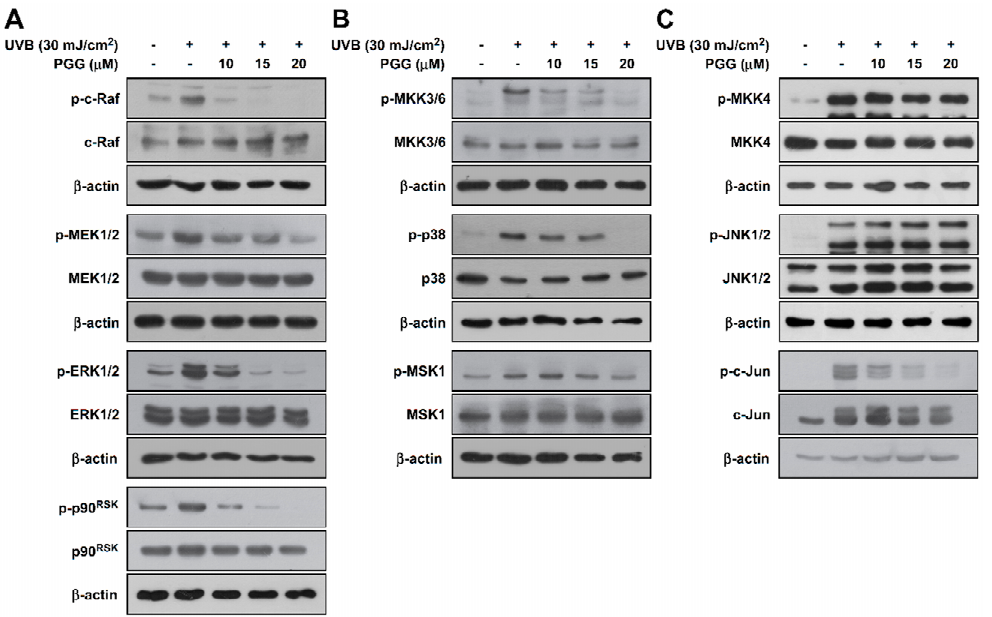
Figure 2. Effect of PGG on UVB-induced MAPK signaling in HaCaT cells. ( A ) Phosphorylation of ERK signaling (RAF, MEK, ERK, p90 RSK ), ( B ) phosphorylation of p38 signaling (MKK3/6, p38, MSK1) and ( C ) phosphorylation of JNK signaling (MKK4, JNK, c-Jun). Cell pretreated with PGG (10, 15 and